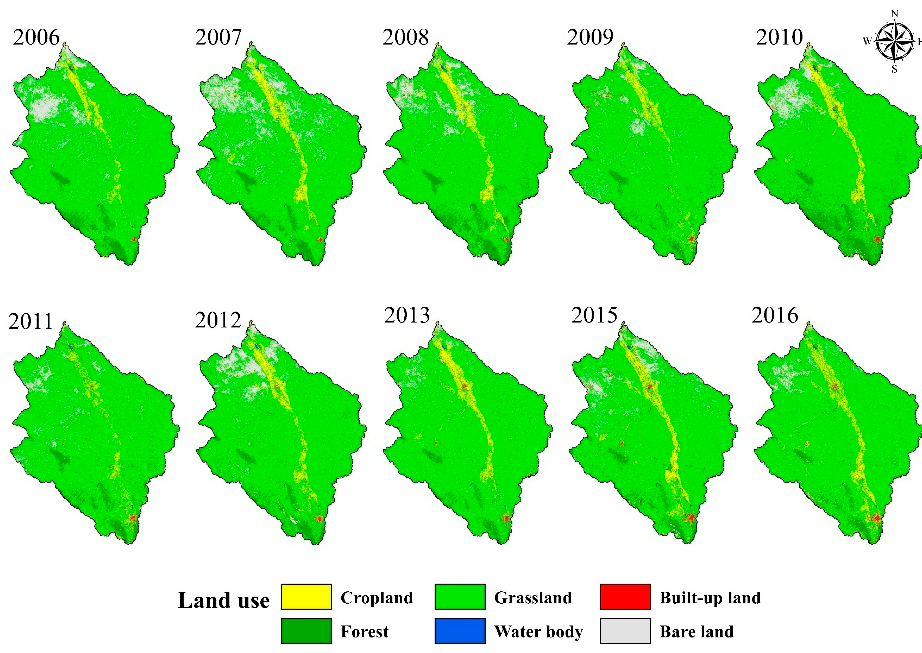
Figure 5. Land use in the QRB from 2006 to 2016.